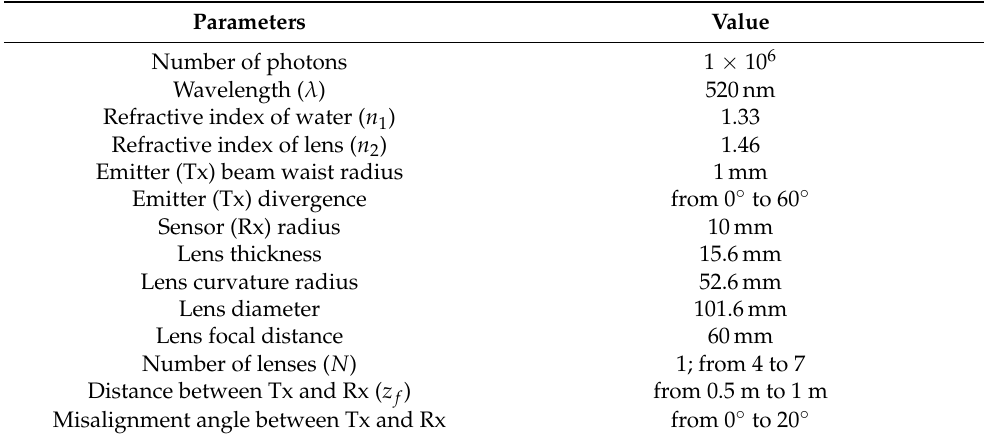
Table 1. Simulation parameters.